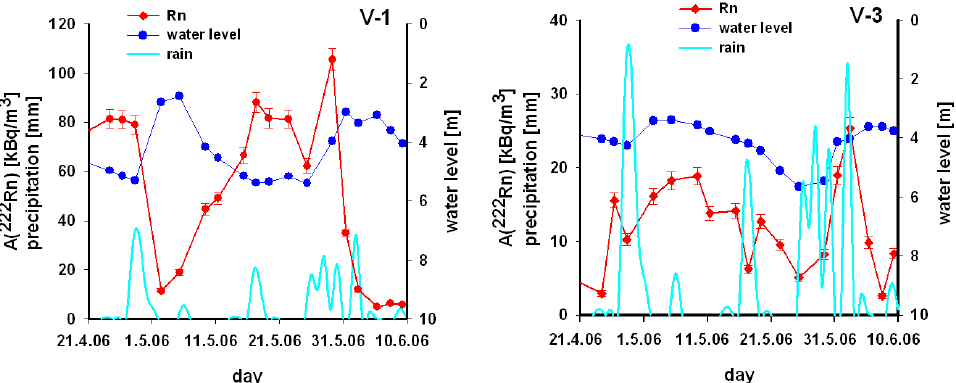
Fig. 2. Variation of radon activity concentration with rainfall in V-1 and V-3 boreholes. Vertical bars represent the standard deviation of the radon activity concentration determination.